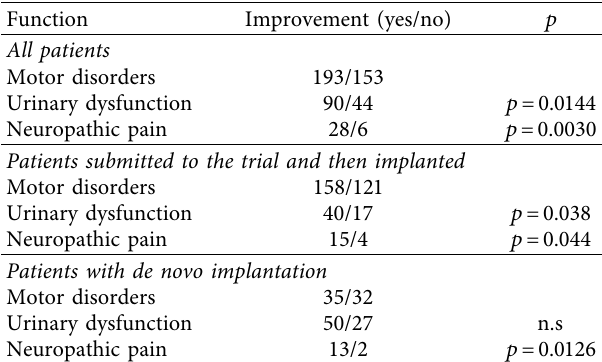
Table 2: Number of MS patients improved after SCS according to the evaluated function.